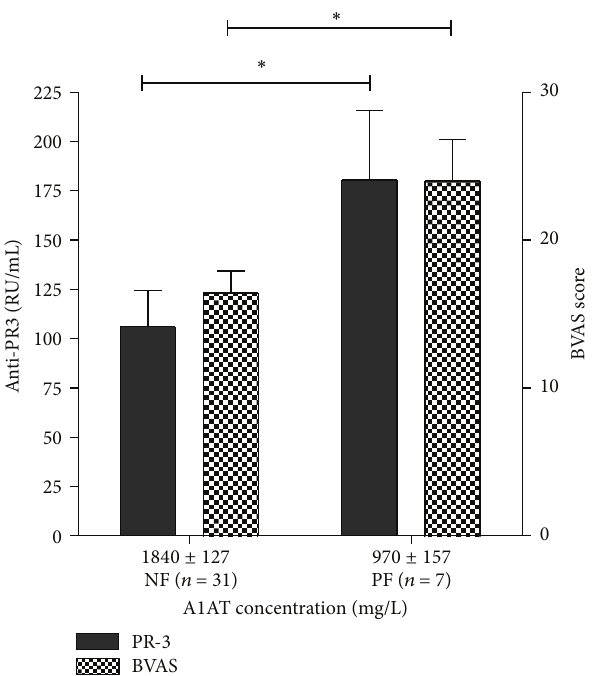
Figure 3: A1AT concentration, anti-PR3 antibodies concentration, and GPA activity in patients with normal and abnormal A1AT PF-patients with pathological A1AT phenotype; A1AT: alpha-1- antitrypsin; PR3: Proteinase 3, anti-PR3: anti-proteinase 3 antibod- ies; GPA: Granulomatosis with polyangiitis; BVAS: Birmingham Vasculitis Activity